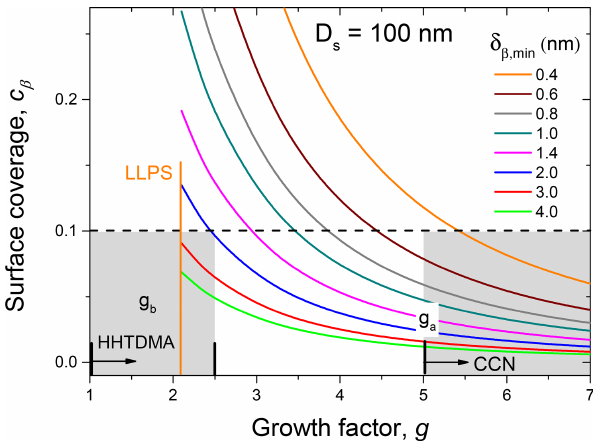
Figure 12. The surface coverage, c β , as a function of particle growth factor, g = D wet /D s with D s = 100nm, obtained for dif- ferent values of the monolayer thickness, δ β, min (colored lines). For HHTDMA and CCN measurements, D s equals D H&D , min and D a , respectively. g a = D wet ,a /D a is the growth factor at the activa- tion diameter; D a ≈ 100nm. The gray areas show the growth factor range of HHTDMA and CCN measurements. The dashed line in- dicates the c β value below which σ ≈ σ w . Both g a and g b growth factors are average values of the birch, pine, and rapeseed